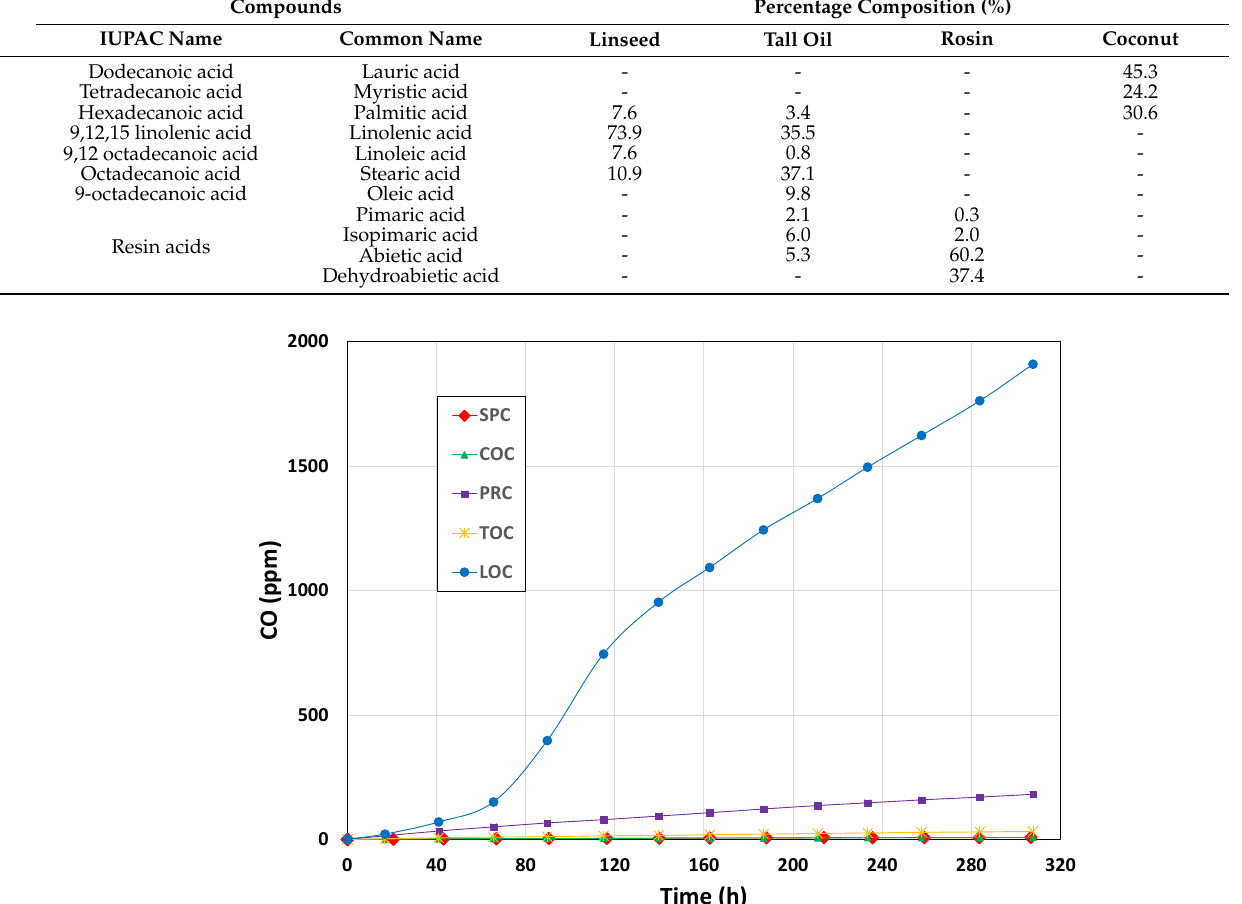
Figure 2. Cumulative carbon dioxide (CO 2 ) mean concentrations in the containers over the thirteen- day test period for each of the five materials. Pellets made from: SPC—100% synthetic pure cellu- lose, COC—cellulose plus 10% coconut oil, PRC—cellulose plus 10% pine rosin, LOC—cellulose plus 10% linseed oil, TOC—cellulose plus 10% tall oil.